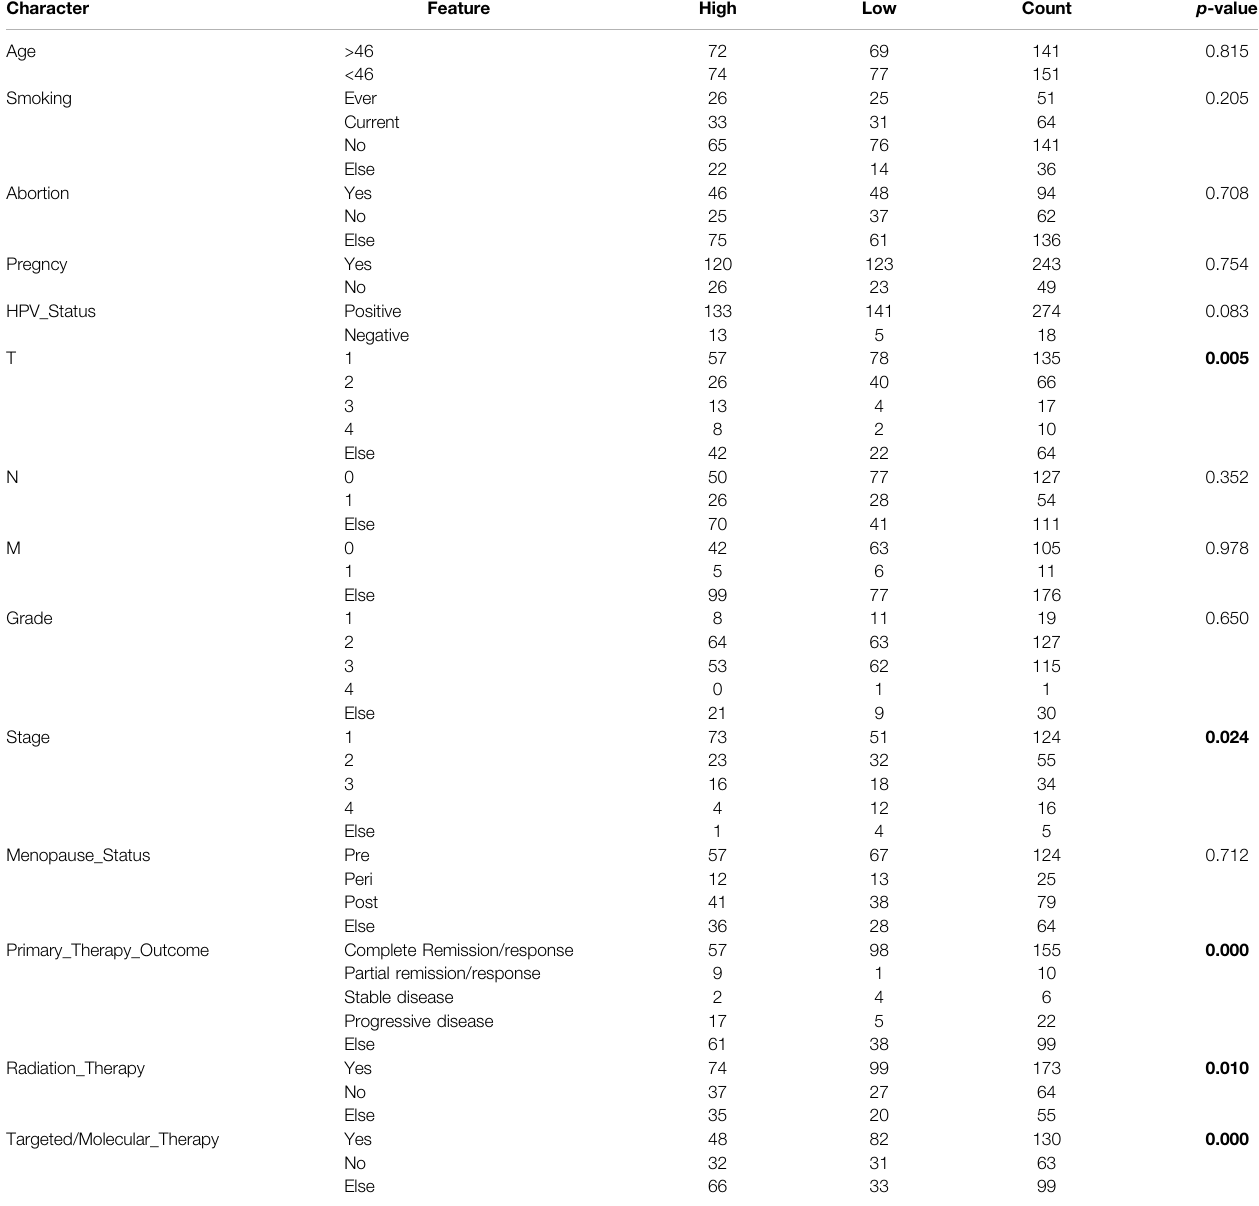
TABLE 5 | Comparison of clinical characteristics based on CPS risk group. Character